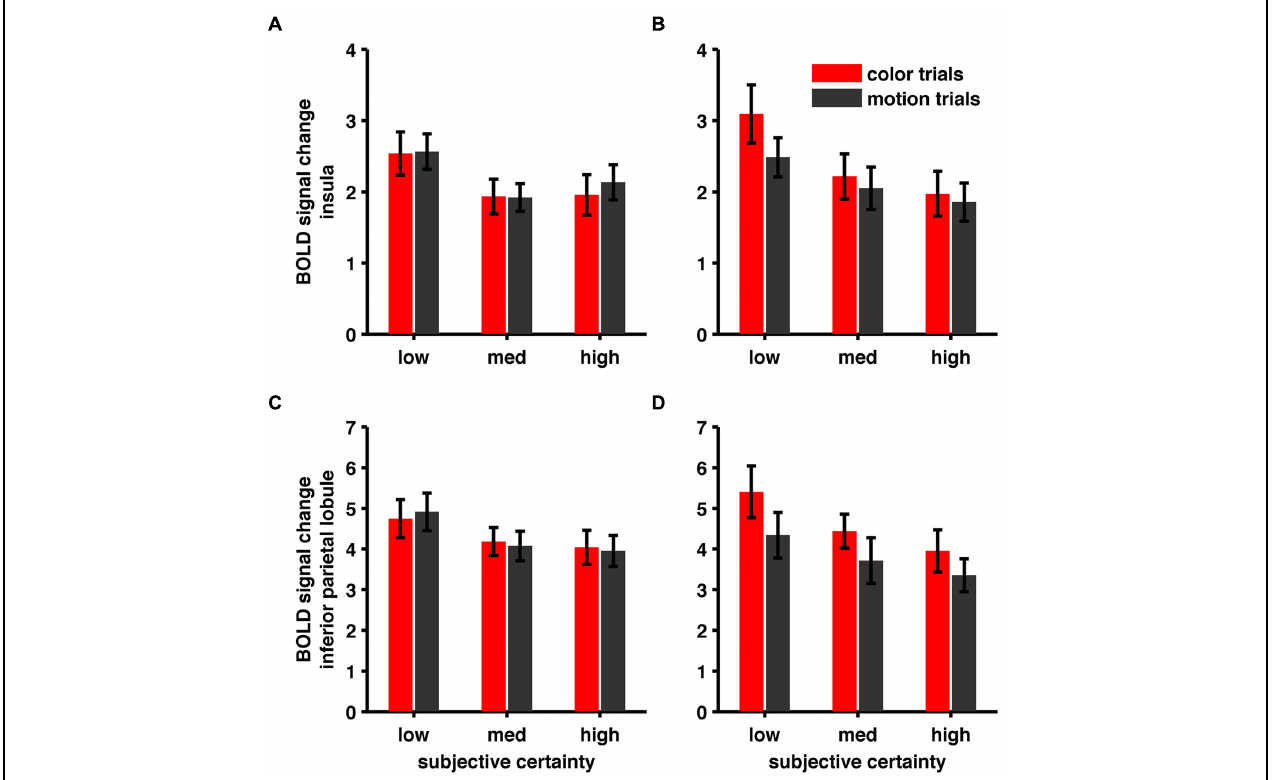
FIGURE 5 | (A) BOLD signal change in Insula (xyz = 33, 17, 4), heterogeneous rating frequencies. (B) BOLD signal change in Insula, homogenized rating frequencies (C) BOLD signal change in inferior parietal lobule (xyz = 39, − 43, 52), heterogeneous rating frequencies. (D) BOLD signal change in inferior parietal lobule, homogenized rating frequencies. TABLE 6 | Conjunction: Areas showing task-independent significant correlations with subjective certainty ratings in both color and motion trials. Region Voxels at p < 0.001 Peak t -score P (cluster FWE corrected) Peak voxel MNI